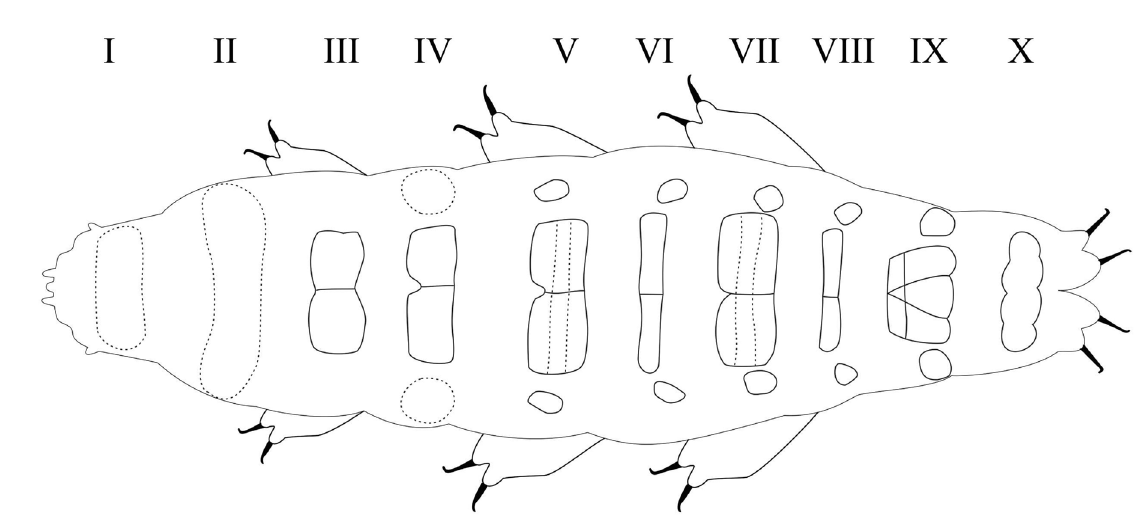
Fig. 5. Semi-schematic drawing of pseudoplate configuration in the young specimens of Milnesium pelufforum sp. nov.